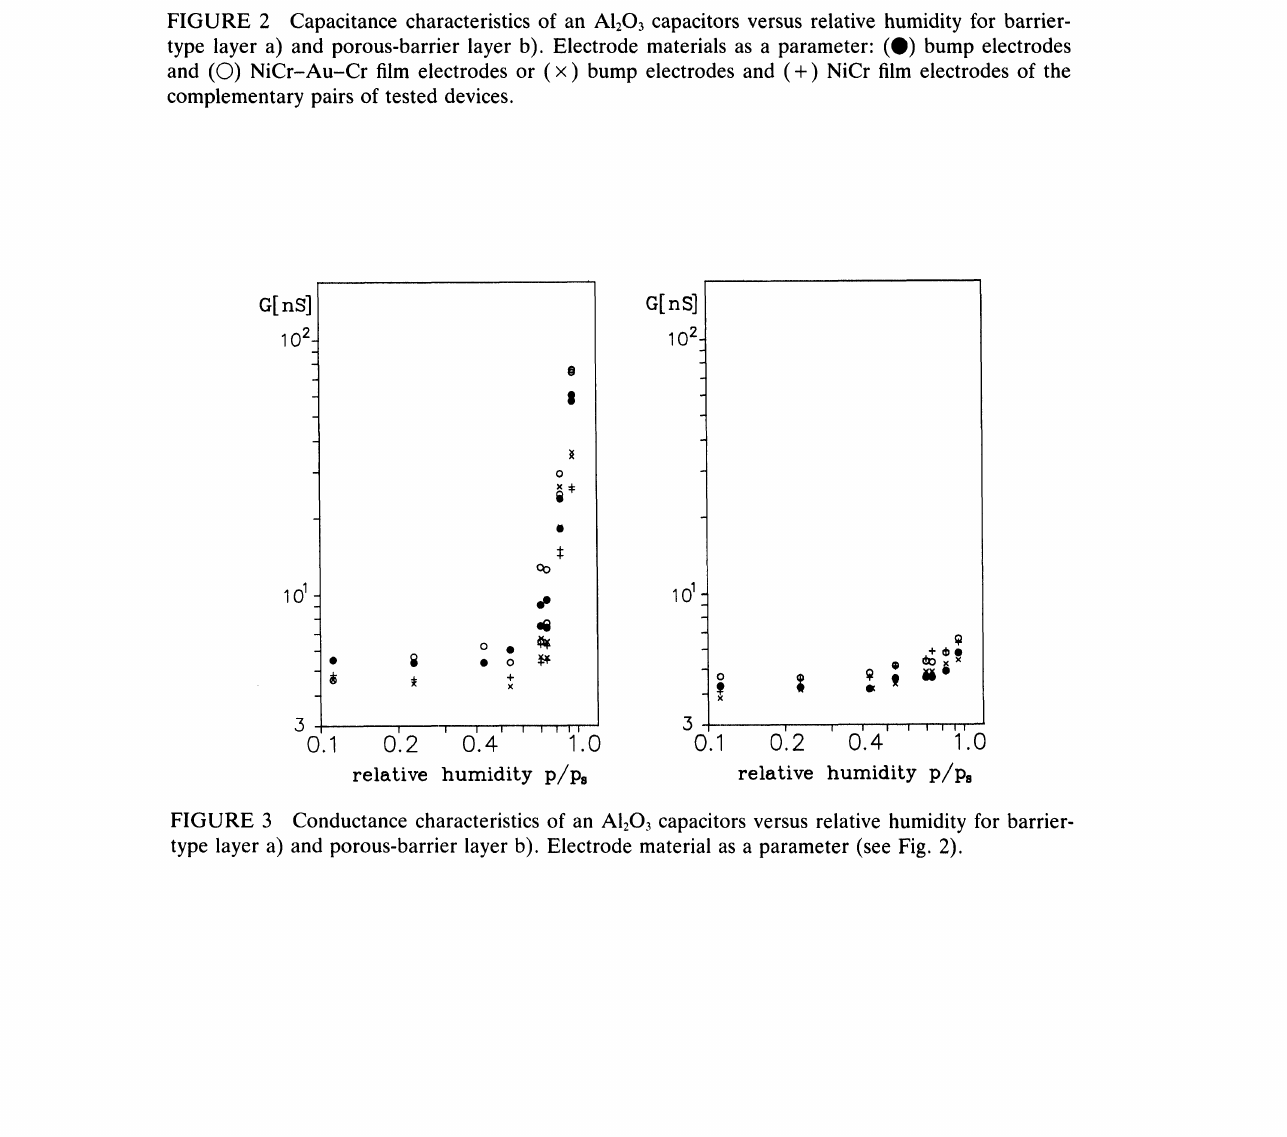
FIGURE 3 Conductance characteristics of an A1203 capacitors versus relative humidity for barrier- type layer a) and porous-barrier layer b). Electrode material as a parameter (see Fig.